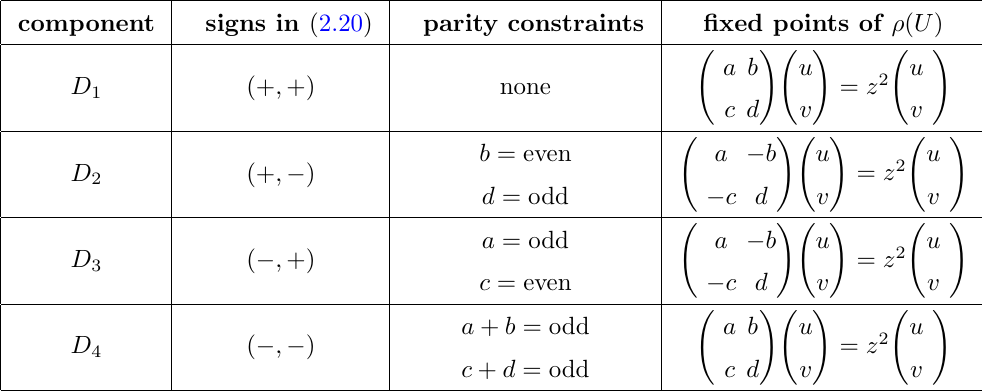
Table 1 . Fixed points of the map (cid:26) ( U ) on the \unipotent" components D i . The (cid:12)xed points exist only when suitable parity constraints are satis(cid:12)ed. The system of equations in the last column is the analogue of (2.27). Here, z denotes the holonomy eigenvalue of SL (2 ; C ) (cid:13)at connection along the base circle in